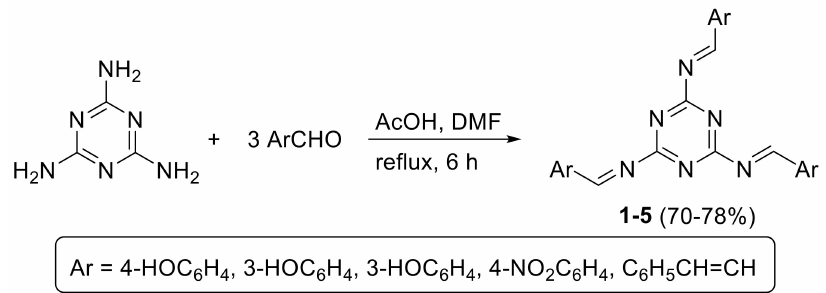
Figure 1. Synthesis of Schiff bases 1 – 5